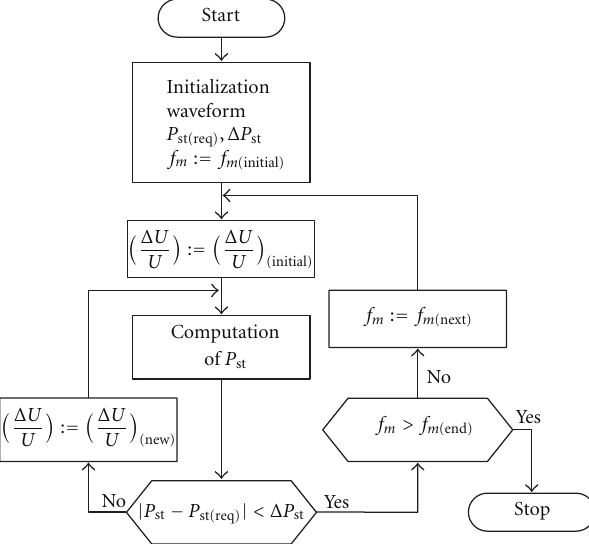
dependence of interharmonic component amplitude U